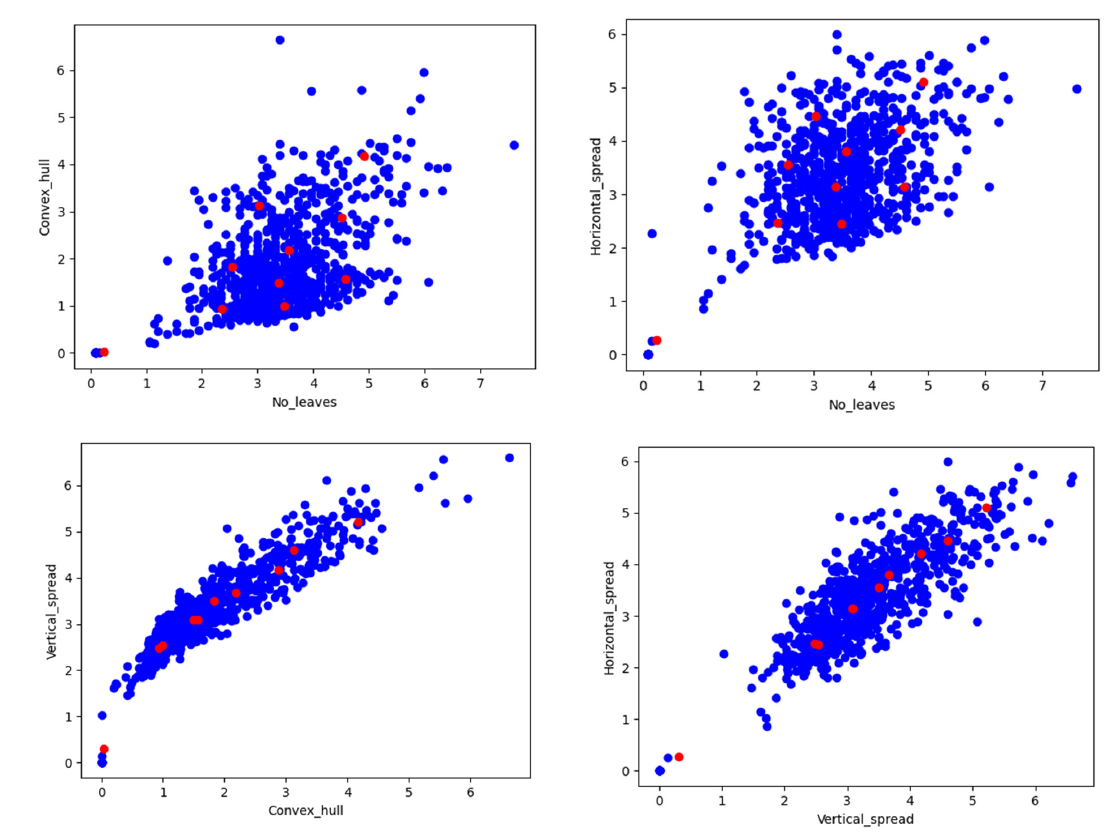
Figure 13. Scatter plot for the number of leaves vs. geometrical properties (convex hull and horizontal spread of the plant); and among geometrical properties of the plant